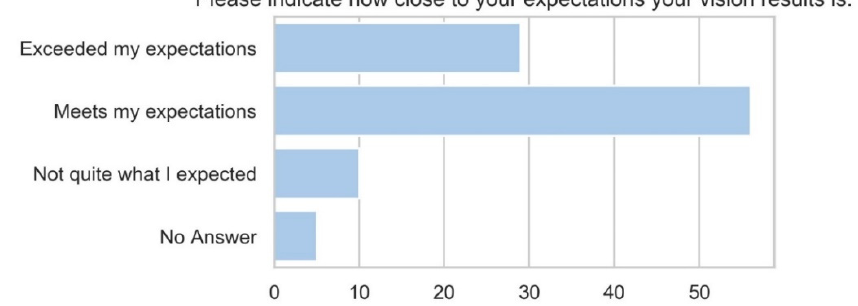
Figure 9. Post ‐ operative Cat ‐ Quest 9 results showing that surgical results met or exceeded patients’